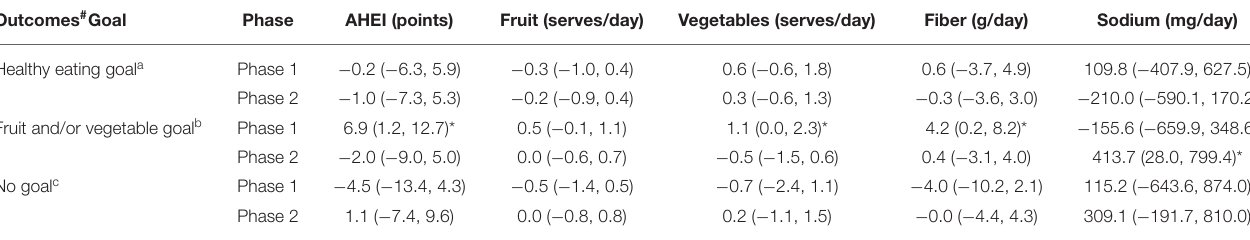
TABLE 3 | Between group changes in AHEI and dietary intake across the two groups of participants who either set a specific goal compared with participants who did not, in each phase of the study. Outcomes #